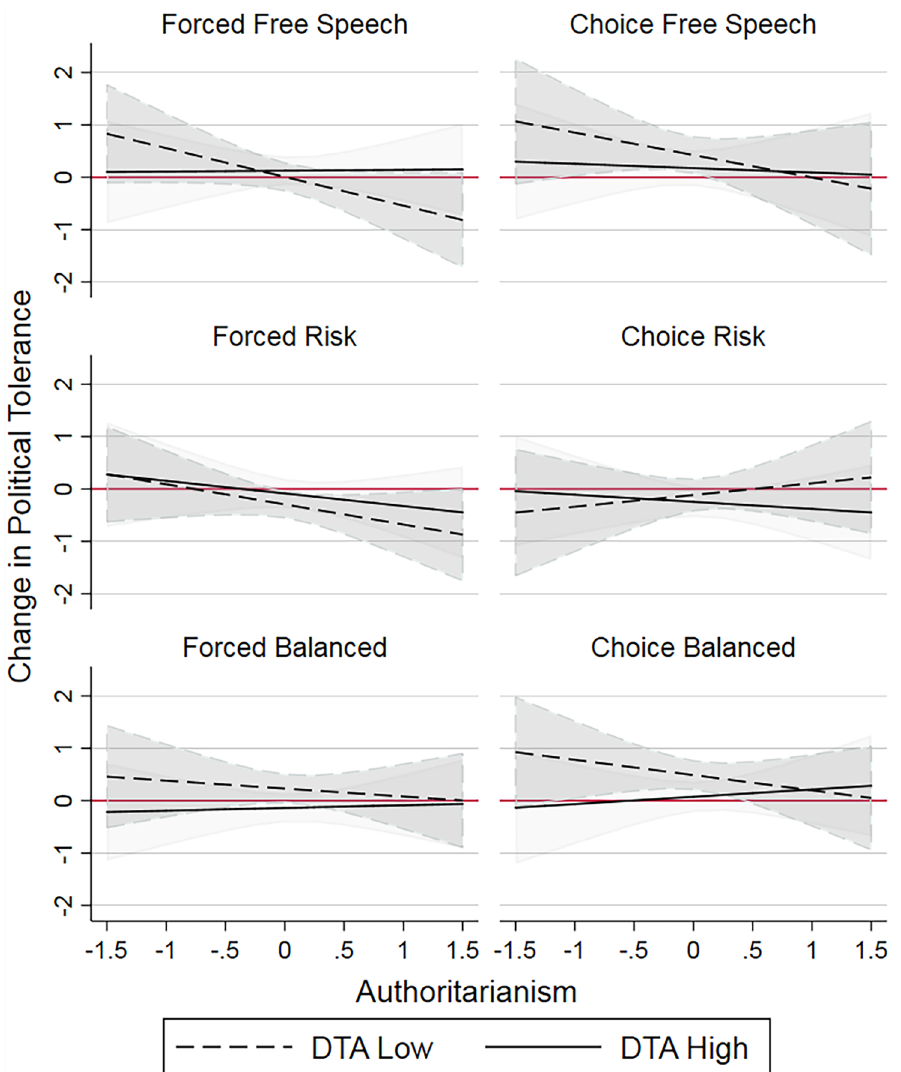
Figure 4. Conditional marginal effects of political messages on political tolerance: USA.